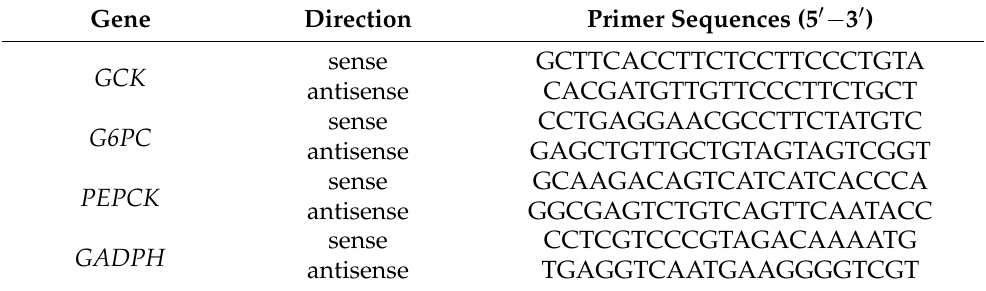
Table 1. Sequences of Primers for